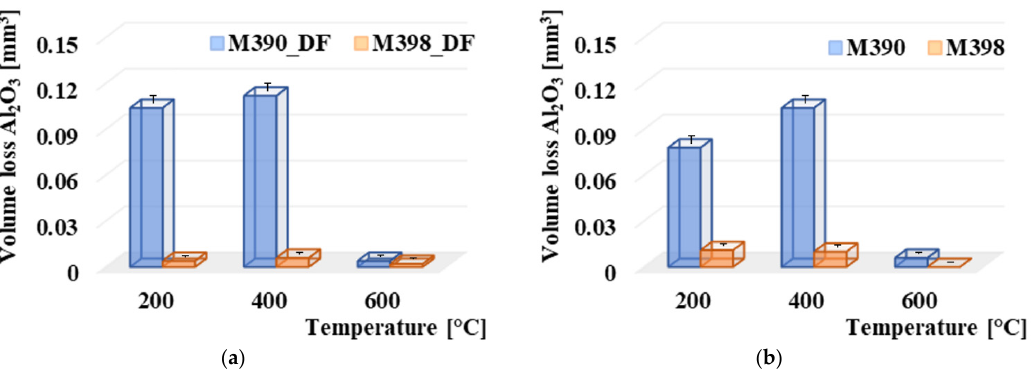
Figure 9. Comparison of volume loss Al 2 O 3 : ( a ) volume loss Al 2 O 3 with M390_DF and M398_DF and ( b ) volume loss Al 2 O 3 with M390 and M398.